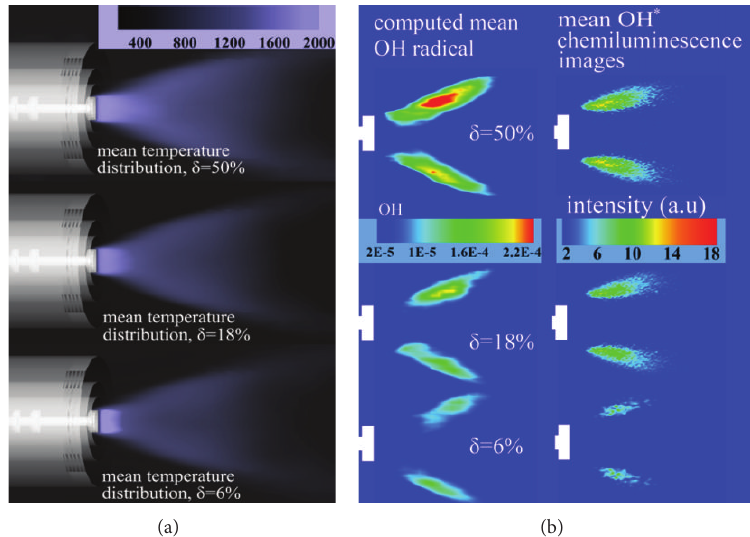
Figure 2: Simulated time-mean disk burner wake characteristics, (a) temperature, (b) OH mole fraction radical and OH ∗ chemiluminescence distributions for various ultra-lean flame settings.